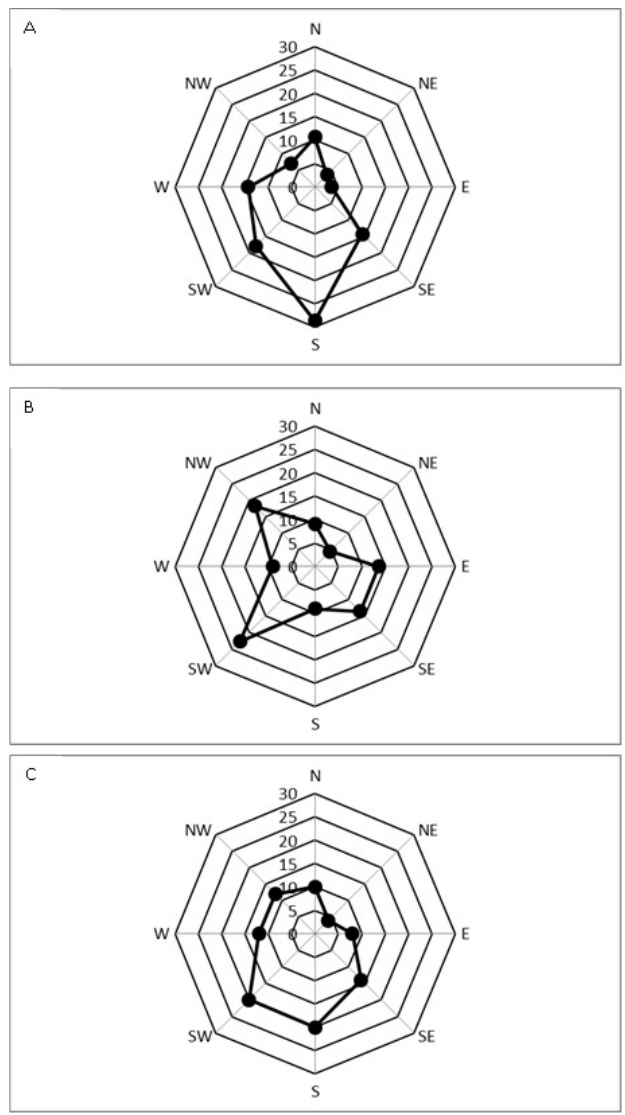
Fig 3 . Number of bee nests (percent) sampled at Almas and Moreiras Farms accordingly to orientation of entrances to cardinal and collateral points, A Almas Farm, B Moreiras Farm, and C